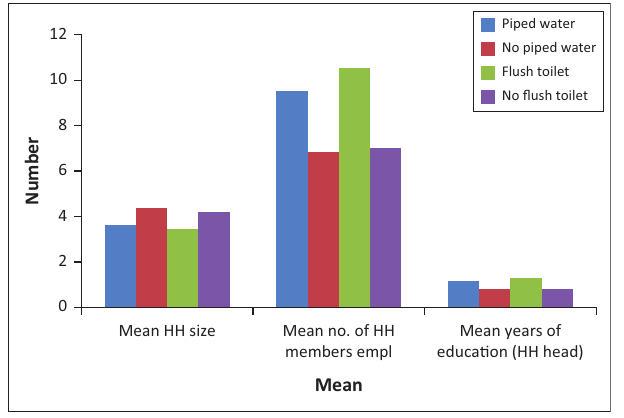
FIGURE 6: Geographic distribution of households with piped water on the